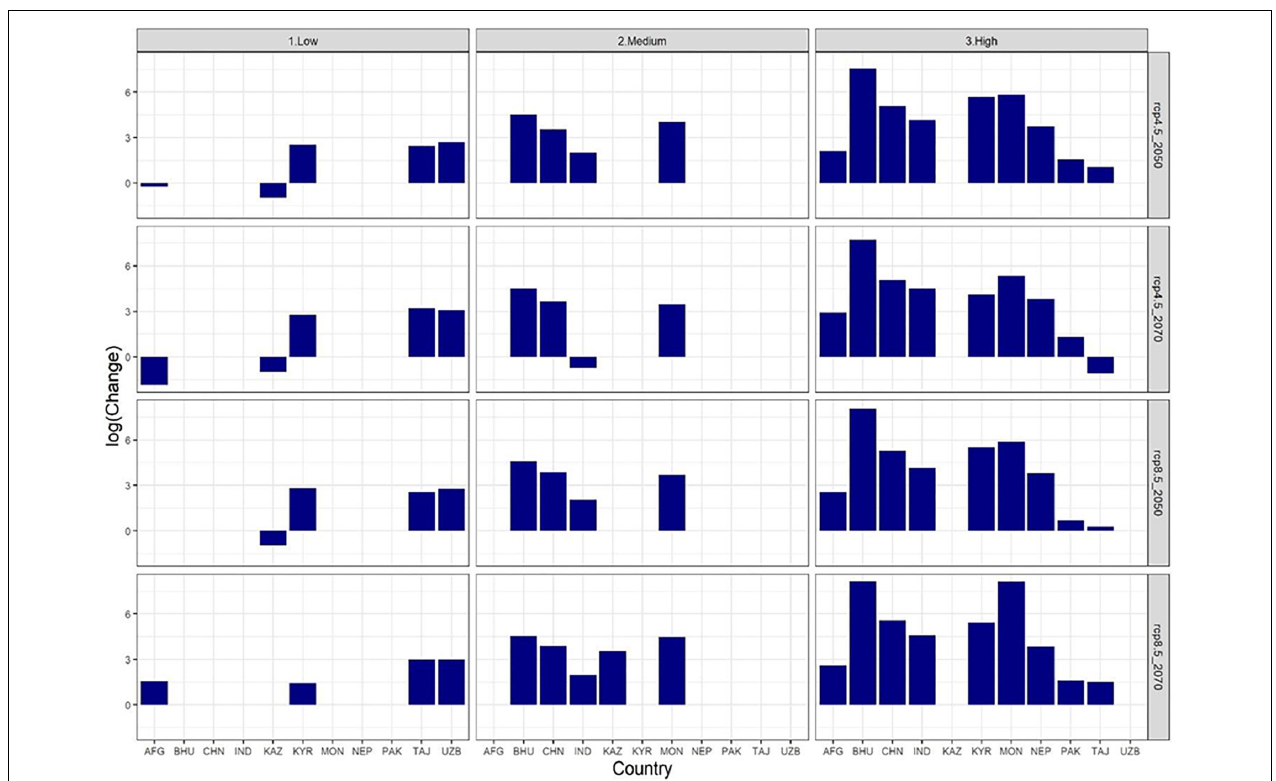
FIGURE 4 | Country-wise gain/loss of wooly wolf suitable habitat in four future scenarios with respect to current suitable habitat in three suitability